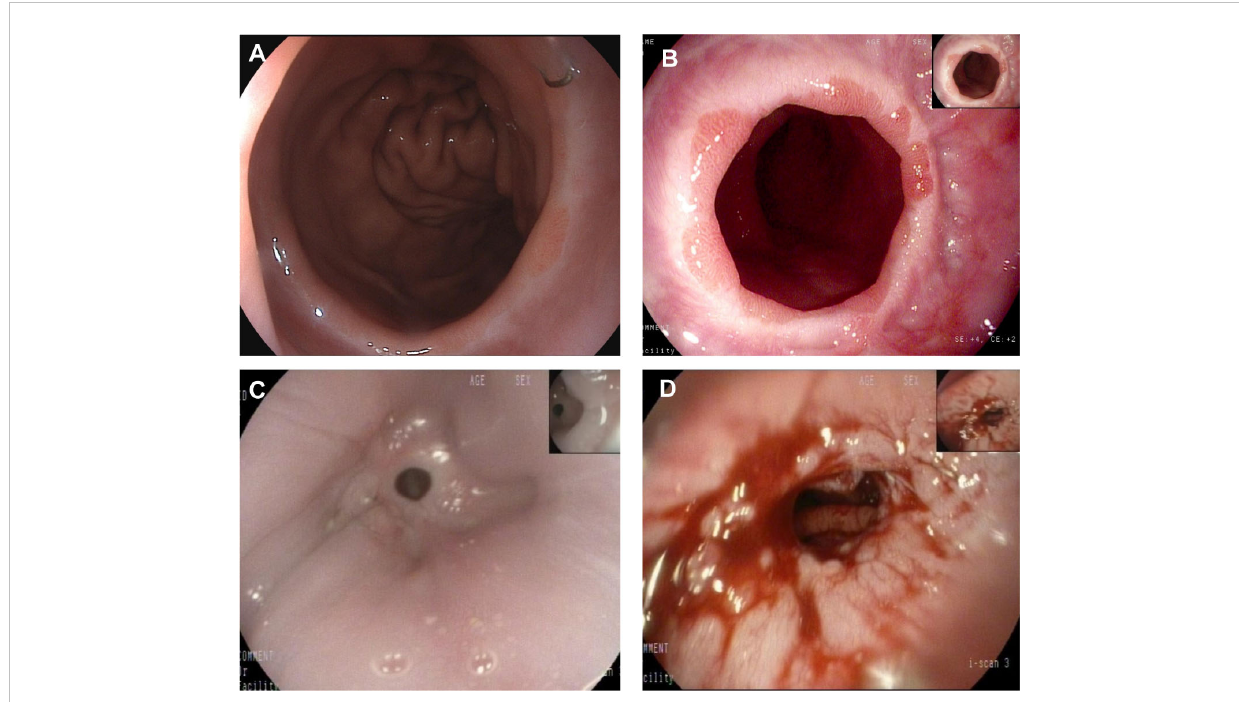
FIGURE 4 A representative gastroscopic image. (A) Normal anastomotic status of the patient after esophagogastric anastomosis; (B) Anastomotic status in patients with re fl ux esophagitis; (C) anastomotic stenosis; (D) Anastomotic status after endoscopic dilation.